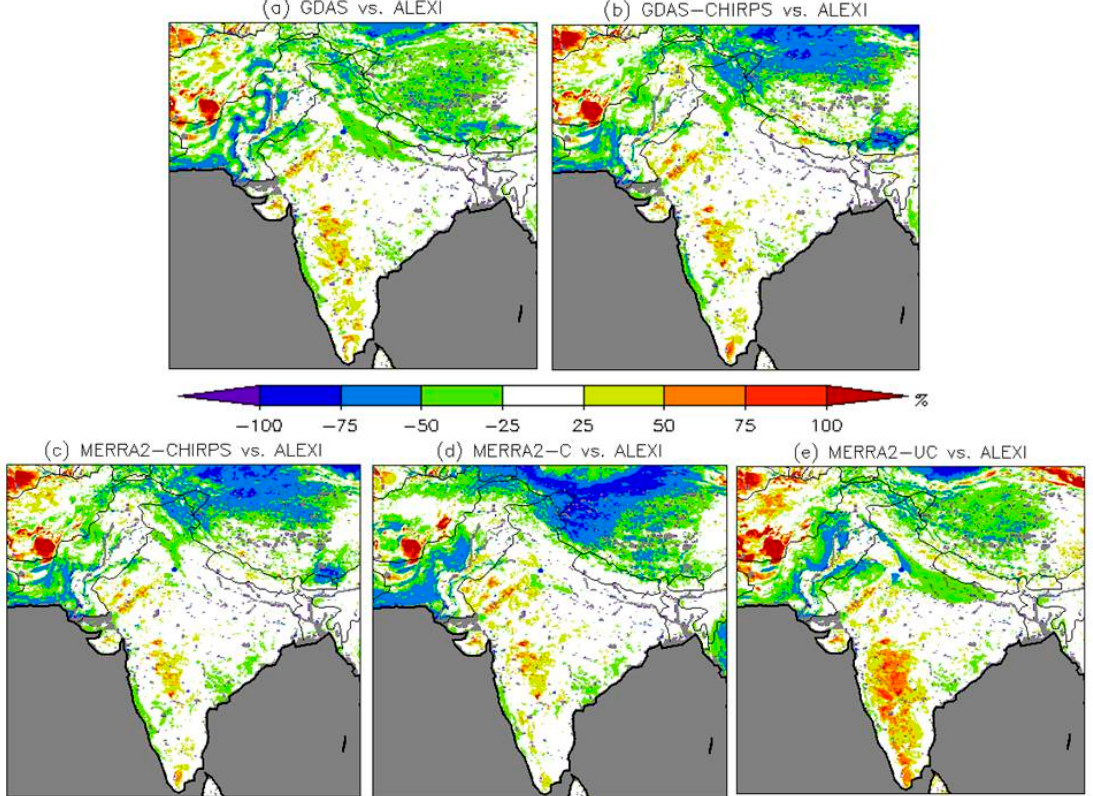
Figure 5. Relative bias of climatology of annual ET based on the period from 2003 to 2015 between ALEXI and model simulations with ( a ) GDAS, ( b ) GDAS-CHIRPS, ( c ) MERRA2-CHIRPS, ( d ) MERRA2-C, and ( e ) MERRA2-UC. The grey color indicates a region with no data.